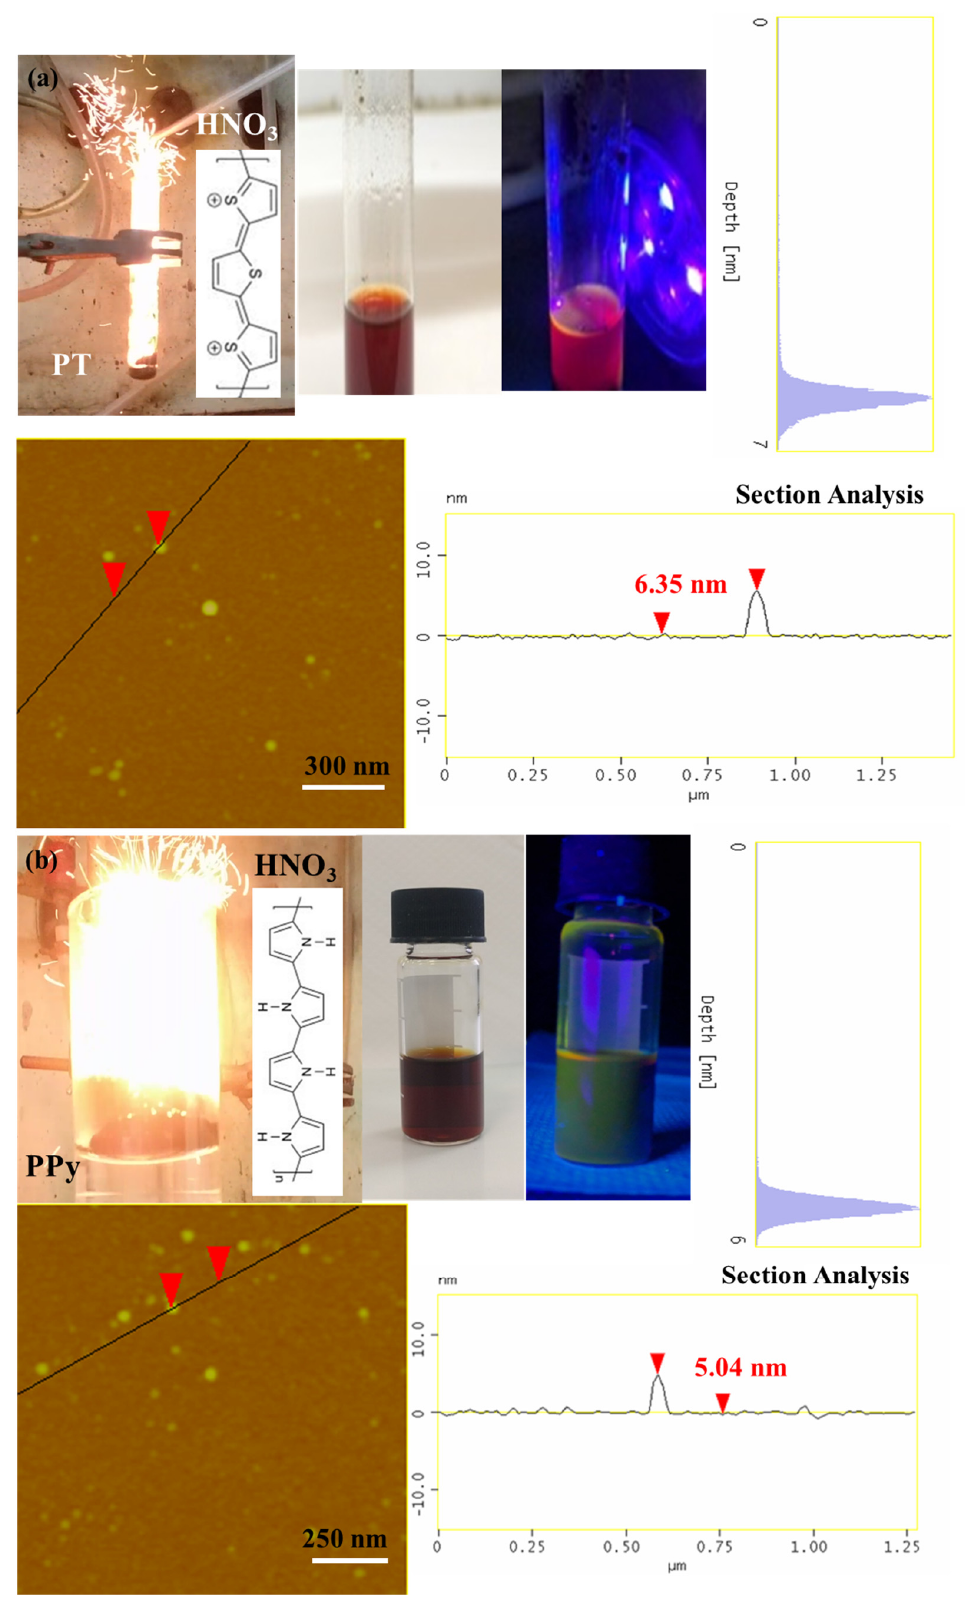
Figure 9. Hypergolic ignition of PT ( a ) and PPy ( b ) by fuming HNO 3 results in photoluminescent carbon dots (see for instance the corresponding acetone dispersions under natural and UV light). The AFM topography images of ( a ) PT- and ( b ) PPy-derived dots along with their section-analysis and depth-analysis histograms are also